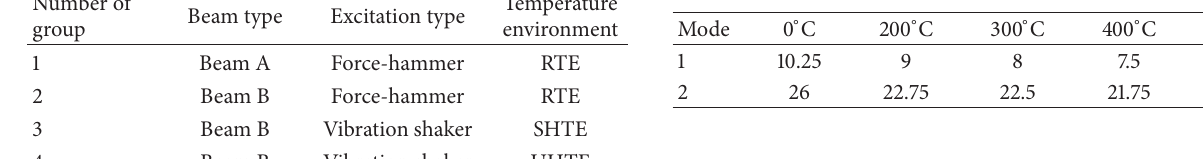
Table 1: Experiment descriptions. Table2:Thefirsttwonaturalfrequencies(Hz)ofbeamBatdifferent